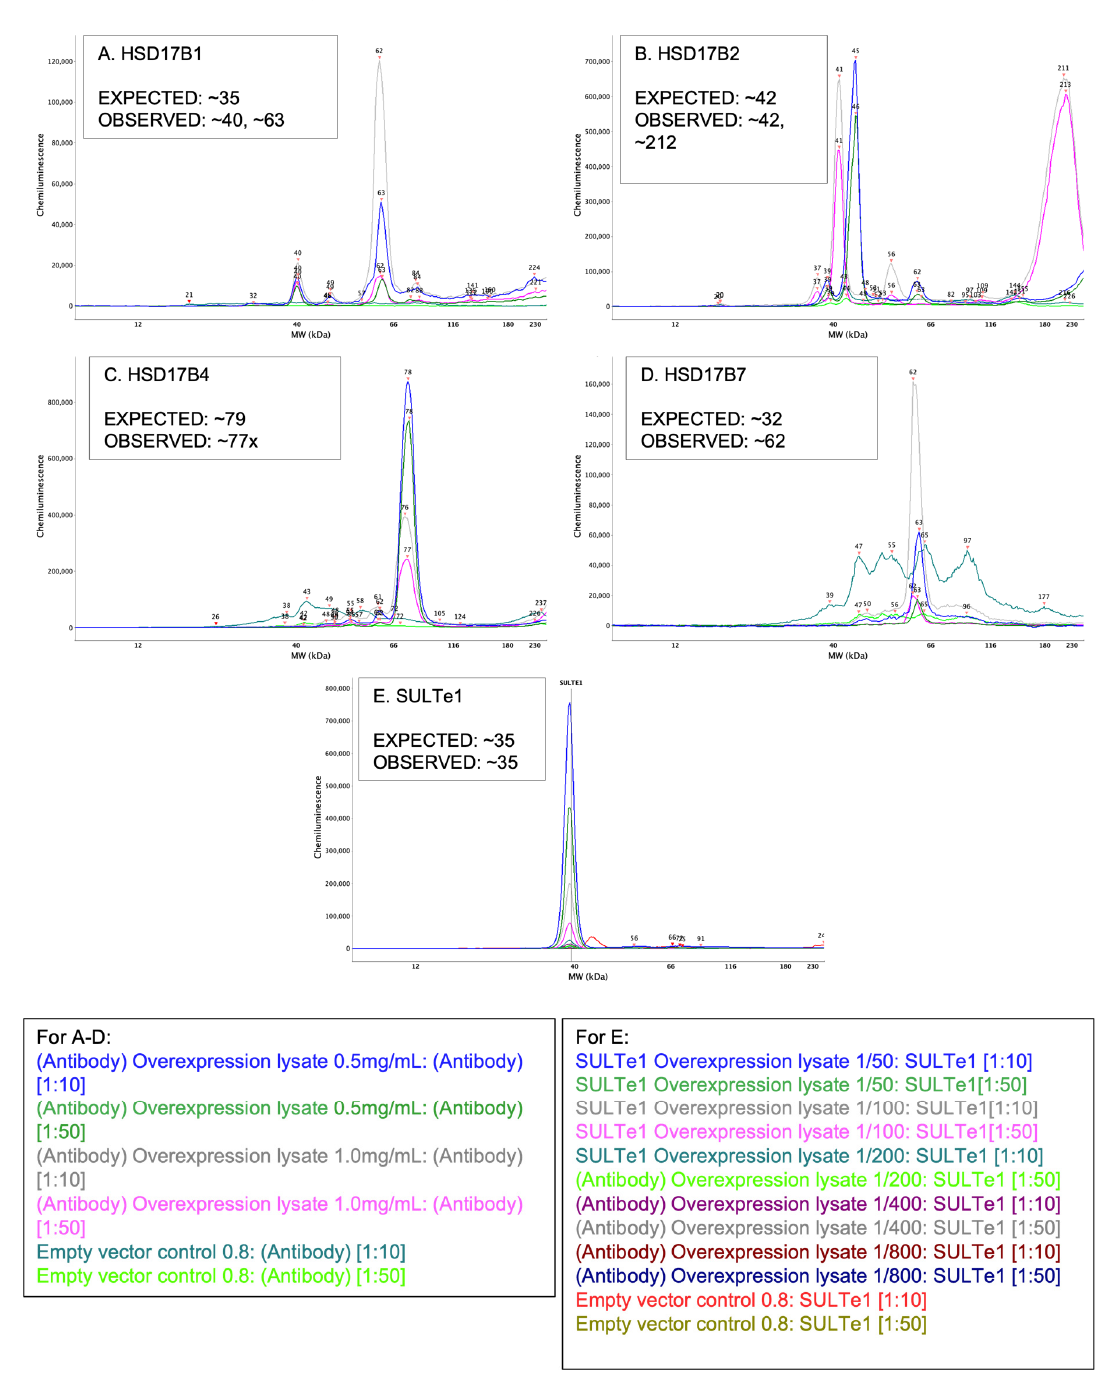
Figure 6. All electropherograms report results from over-expresser lysates at concentrations of 0.5 and 0.8 mg/mL ( A – D ) except for SULTe1 which was tested at: 1/50, 1/100, 1/200, 1/400, 1/800. Empty vector negative controls are also displayed on each electropherogram. Lysates were paired with antibody concentrations of 1:10 and 1:50. Data are listed as follows: ( A ) HSD17ß1, ( B ) HSD17ß2, ( C ) HSD17ß4, ( D ) HSD17ß7, and ( E )